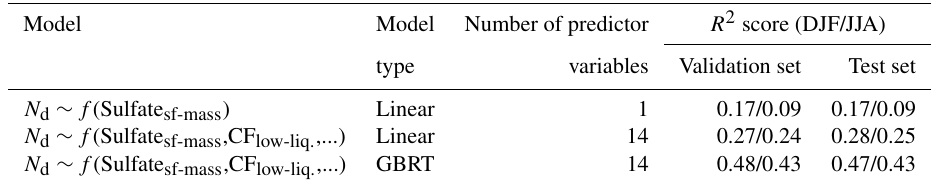
Figure 8. Seasonal climatology of sea level pressure (SLP) (middle column) and anomalies from seasonal averages for low- N d days (left column) and high- N d days (right column). In the left and right columns, red and blue contours are associated with positive and negative anomalies from the climatology, respectively. The green box represents sub-domain C-N for which the analysis was conducted. Table 5. Performance of different models in predicting N d assessed based on average R 2 scores on both validation and test sets. The models were fitted separately for DJF and JJA seasons. Table 2 has the complete list of variables used in the GBRT